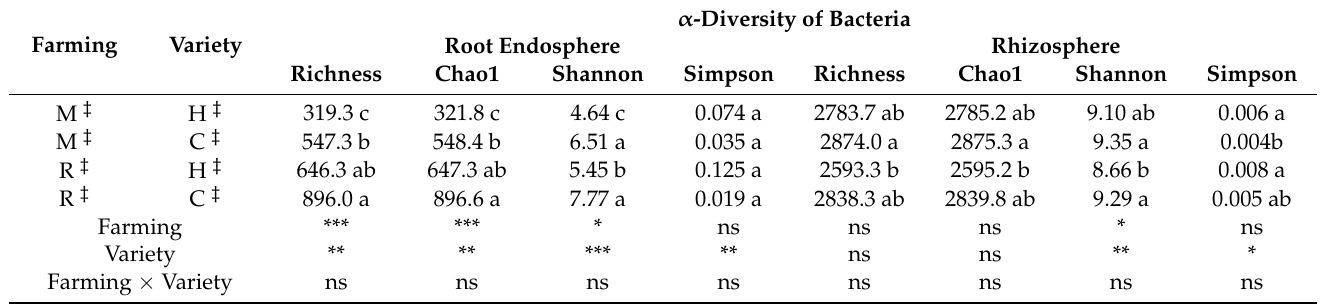
Table 1. The α -diversity of bacteria in the root endosphere and rhizosphere in different varieties under different farming modes.